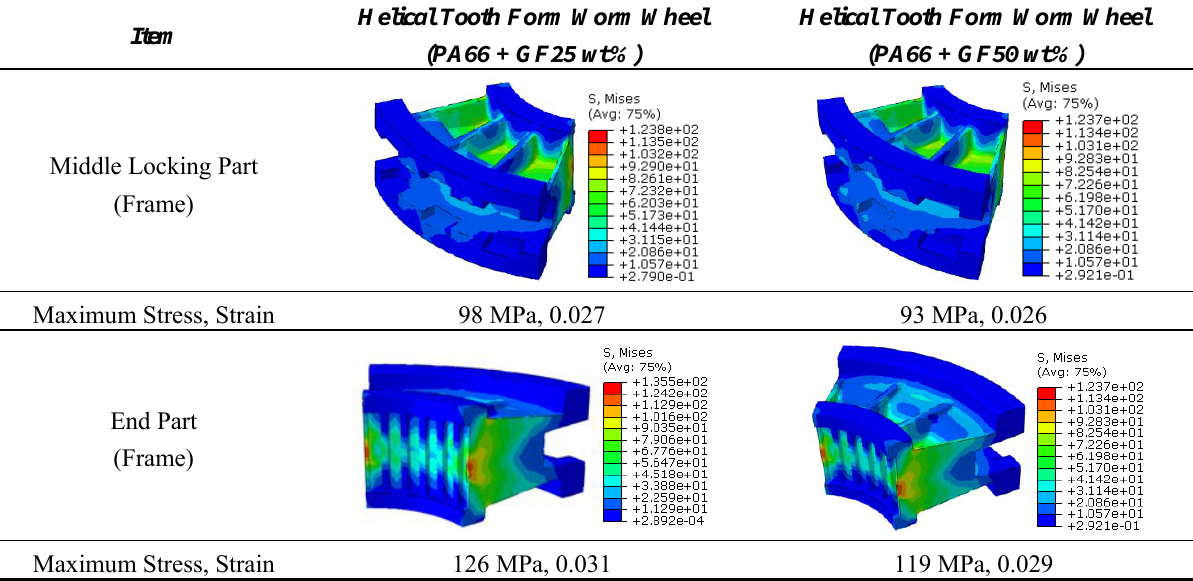
Table 4. Strain-stress comparison analysis according to glass fiber